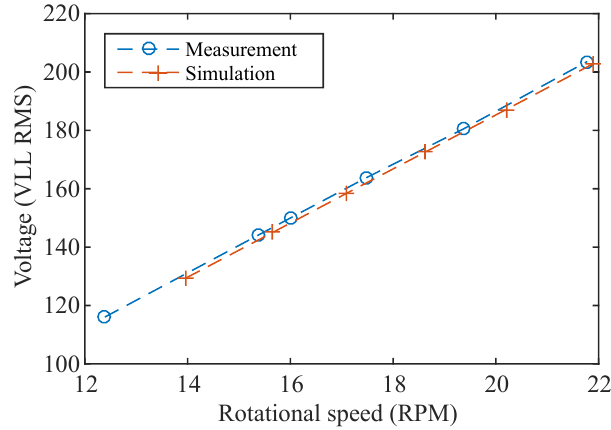
Figure 4. The generator no load line-to-line RMS-voltage.